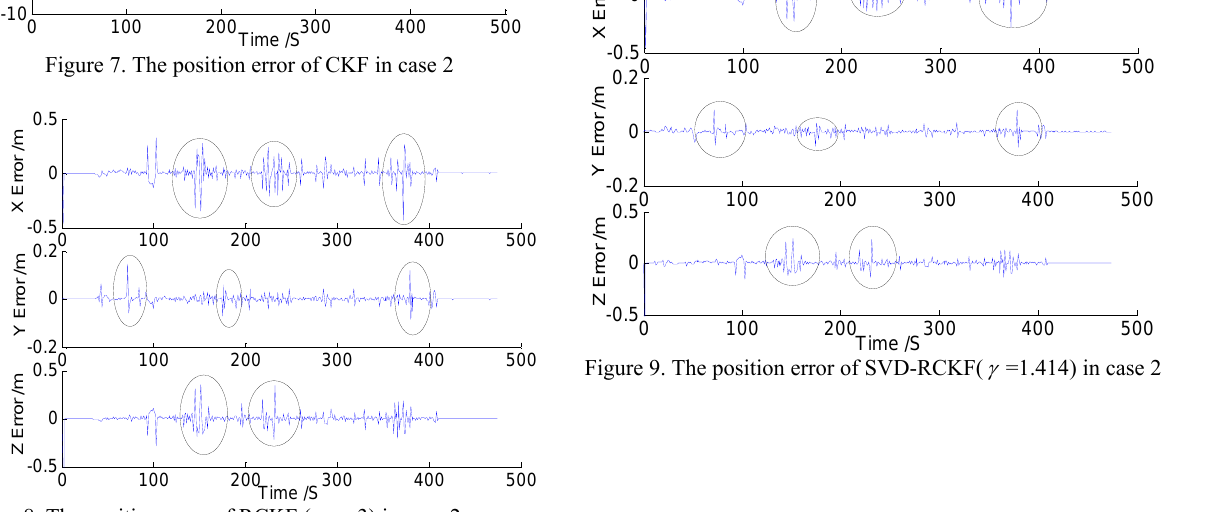
Figure 8. The position error of RCKF (  = 3) in case 2